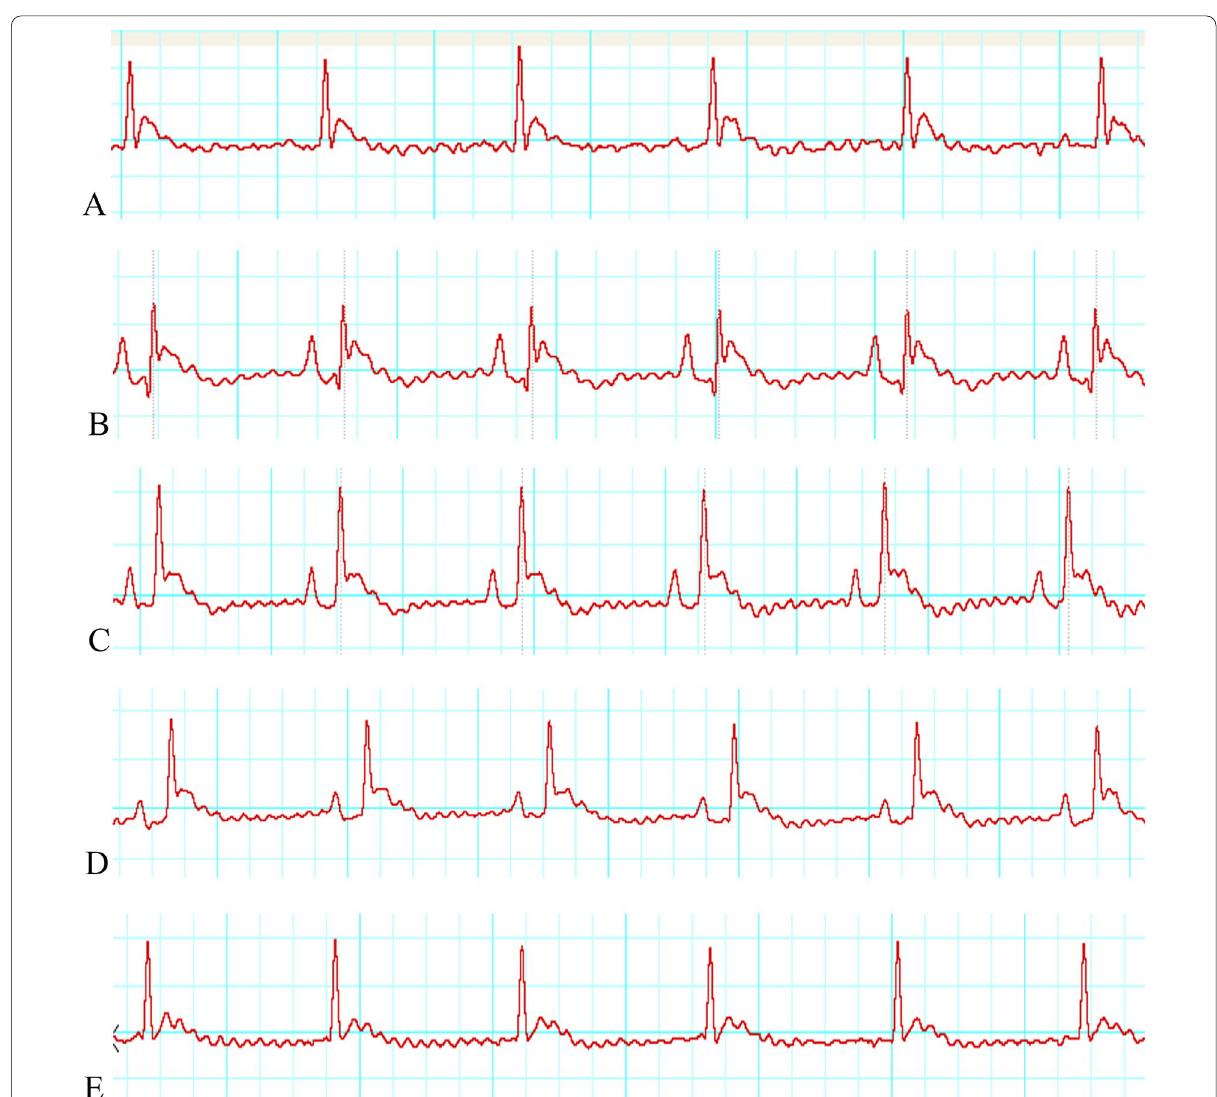
Fig. 2 ECG tracing in the different studied groups: a Normal control group, b ISO induced MI, showing significant increase of HR, decrease of R amplitude and elevation of ST segment as compared to normal group, c Metformin treated group, d Sitagliptin treated group, e Dapagliflozin treated group showing significant reduction of HR, ST amplitude and QT interval as compared to other treated